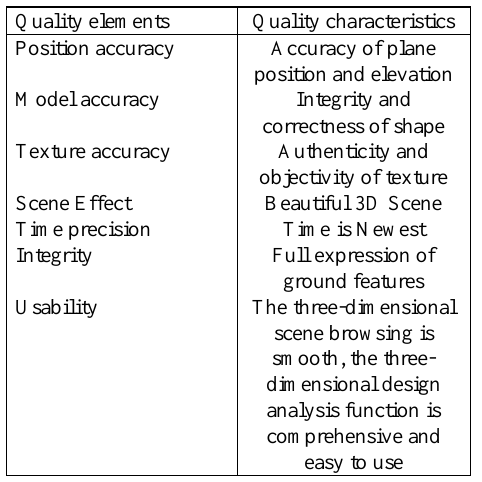
Table 2 . The relationship between the quality elements and the quality characteristics.